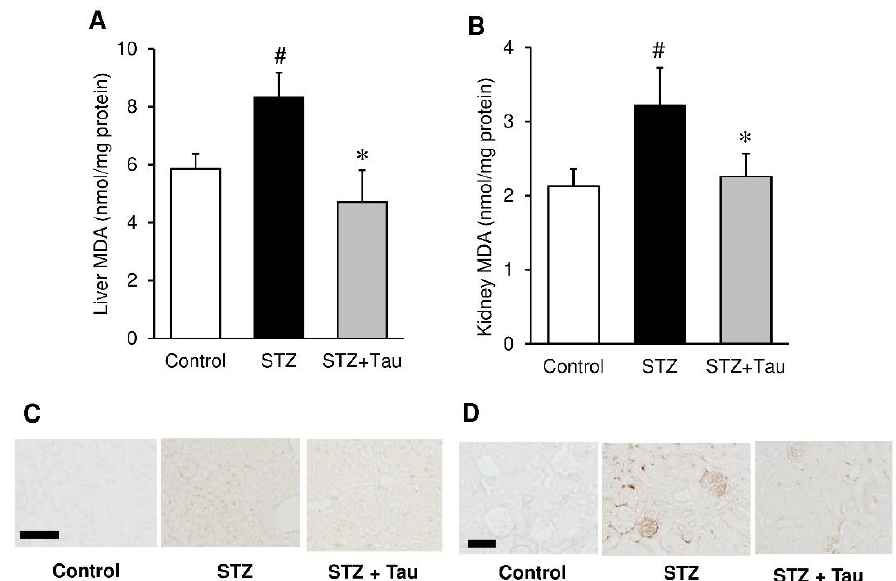
Figure 7. Effects of taurine supplementation on tissue oxidative stress in diabetic mice. MDA levels in liver ( A ) and kidney ( B ) were measured as an oxidative stress marker. Immunostaining 8-OHdG was performed in the liver ( C ) and kidney ( D ). Each value is expressed as the mean ± S.D. ( n = 7–8), # p < 0.05 vs Control group, * p < 0.05 vs. STZ group. Scale bar = 100 µ m.